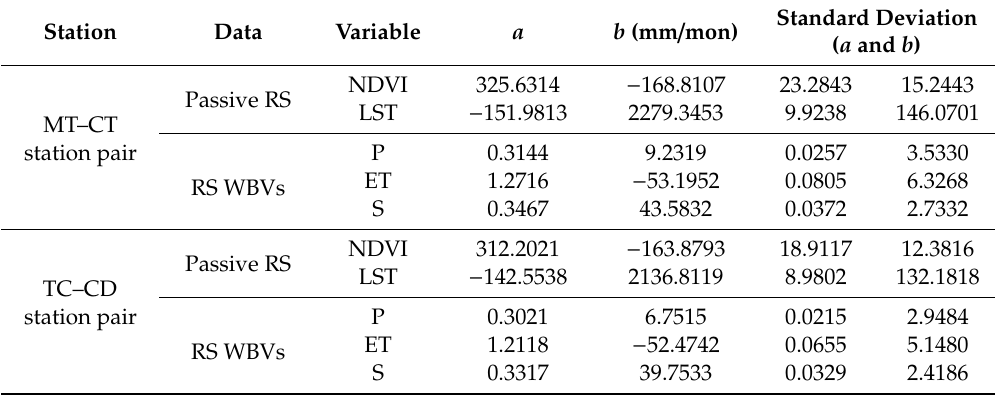
Figure 4. Time series of ground-observed runo ff against remotely-sensed ( a ) TRMM- P , ( b ) MODIS- ET , and ( c ) GRACE- S values averaged over the whole upstream area from the Tibetan Plateau to the southern boundary of Cambodia at the TC–CD station pair. Table1. Runo ff reconstructionparametersbetweentheground-observedruno ff andtheremotely-sensed water balance variables at MT–CT and TC–CD station pairs for Yunnan